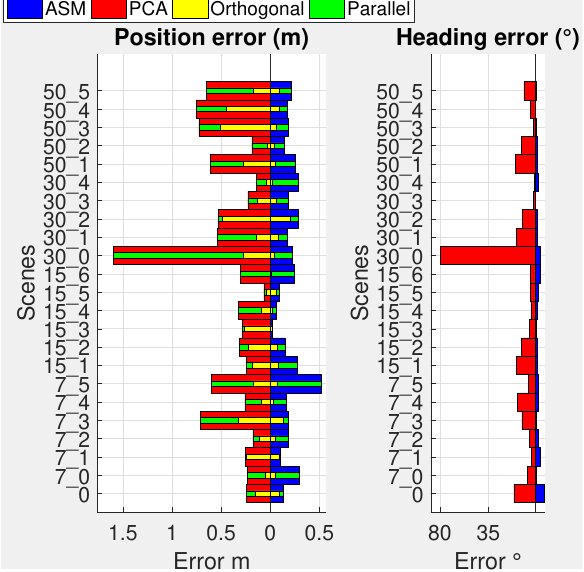
Figure 10. The absolute errors of the detections for the van in the HDL-64 scans. The position error (left) includes the error ratio orthogonal (yellow) and parallel (green) to the van